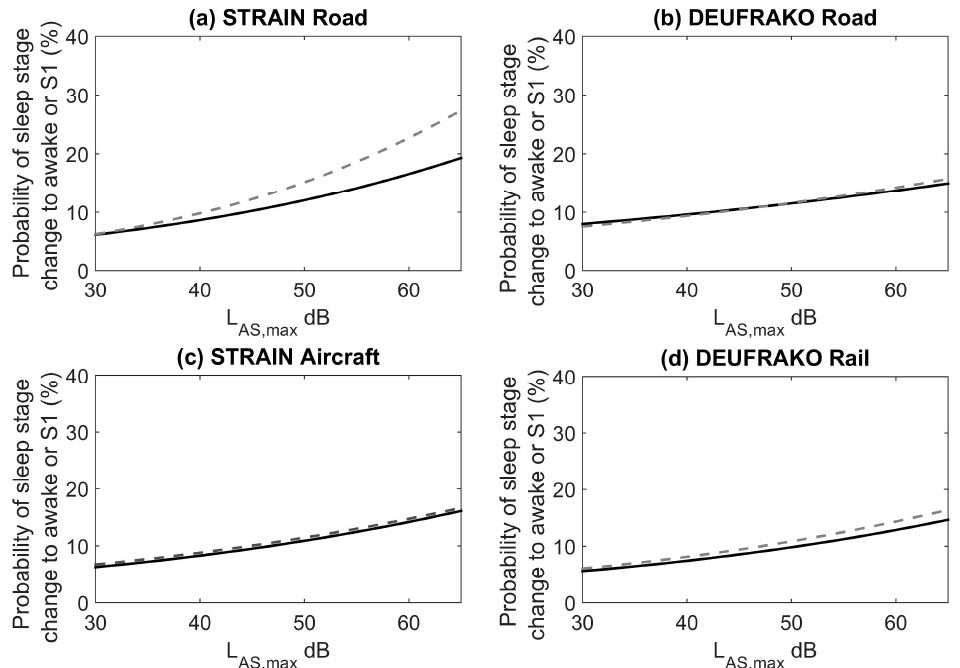
Figure 3. Probability of a sleep stage change to awake or S1 in a 90 second time window following noise event onset depending on the maximum indoor sound pressure level (L AS,max ) for ( a ) STRAIN road traffic ( N = 61 subjects); ( b ) DEUFRAKO road traffic ( N = 33); ( c ) STRAIN aircraft ( N = 61); and ( d ) DEUFRAKO rail noise events ( N = 33). Undisturbed events only (black), all events including disturbed and undisturbed events (gray dotted line).